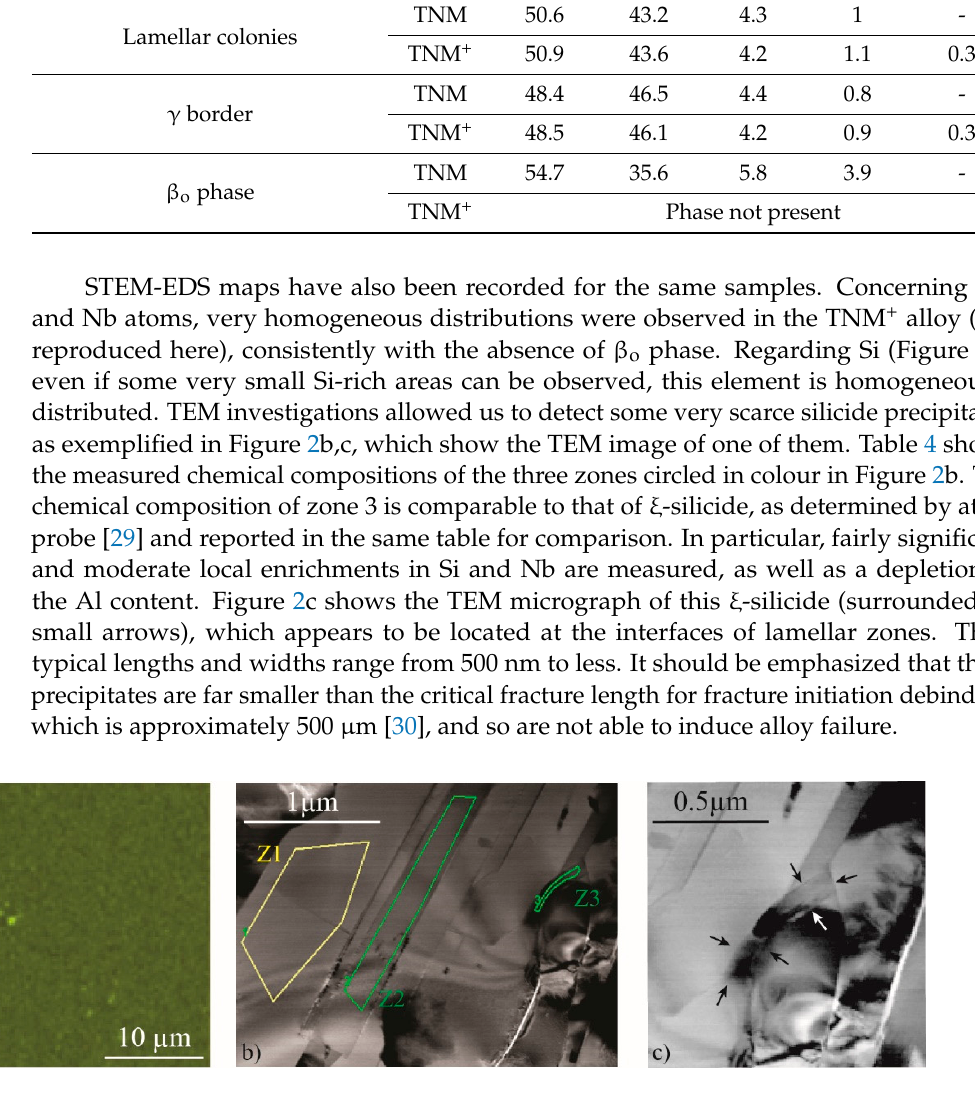
Table 3. Quantitative elemental analysis by EDS at the local scale of the TNM and TNM + alloys densified at 1325 ◦ C. The size of the analysed area was adapted to the size of the investigated features of the microstructure. The values are given in at.% and the accuracy of these measurement is within 0.2.